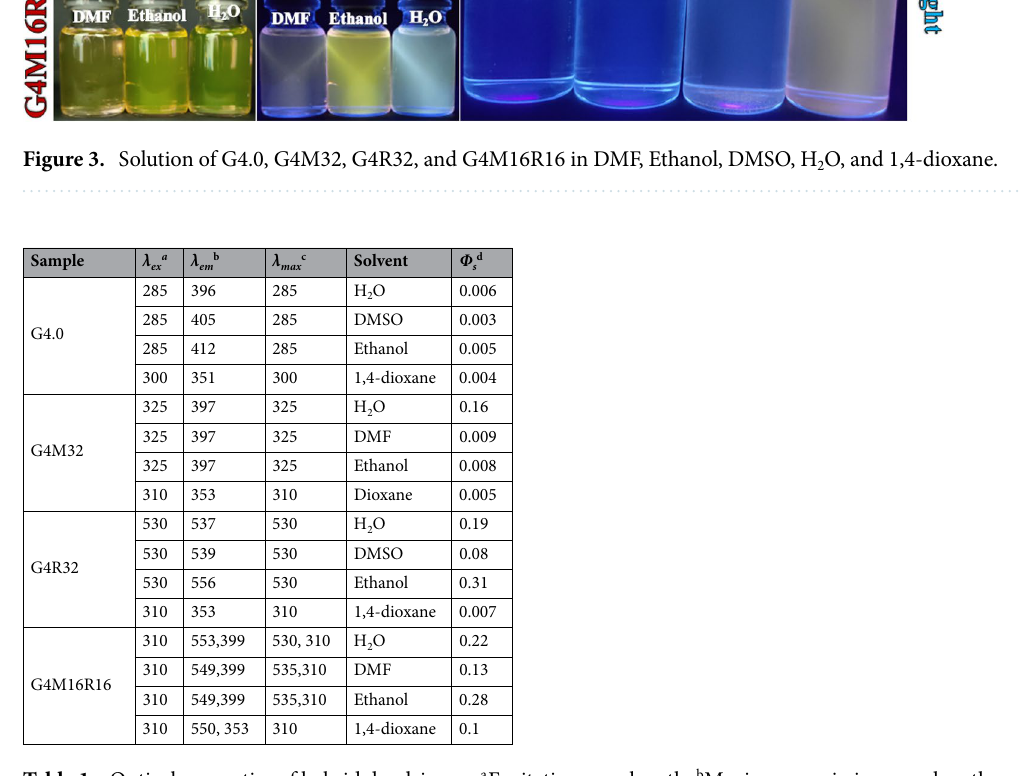
Table 1. Optical properties of hybrid dendrimers. a Excitation wavelength, b Maximum emission wavelength, c Maximum absorption wavelength, d Fluorescence quantum